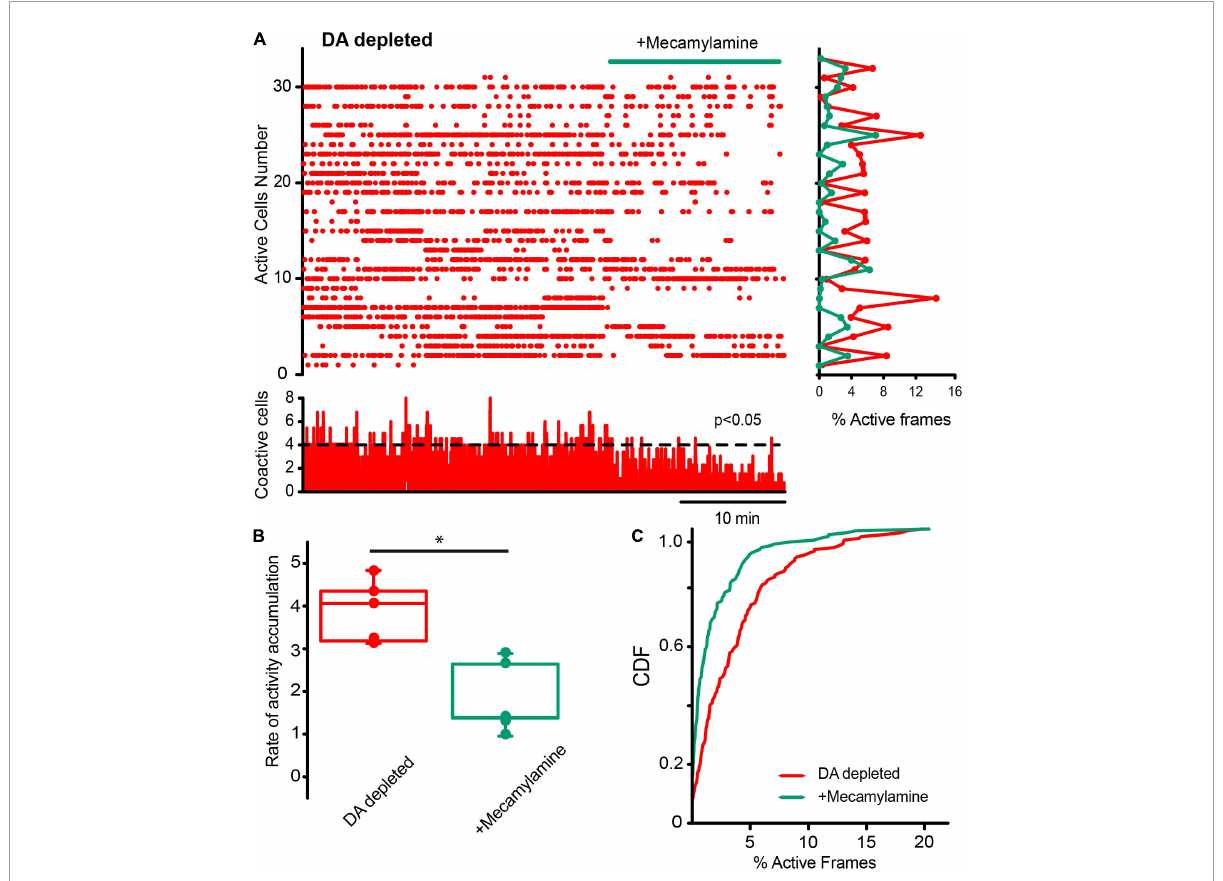
FIGURE12 Cholinergic synaptic transmission via nicotinic receptors is also important to maintain cholinergic interneurons hyperactivity in DA-depleted tissue. (A) Raster plot shows CINs hyperactivity in DA-depleted conditions. The addition of 10 µ M of mecamylamine, a nicotinic receptor antagonist, appears to decrease this hyperactivity neuron by neuron (histogram at right) and in significant peaks of coactivity (histogram at the bottom). (B) Box plots show that the rate of activity accumulation along time is, in fact, decreased ( n = 6; P = 0.05; Wilcoxon T -test). (C) CDFs show differences between activity of CINs during DA-depleted conditions before and after mecamylamine: P < 0.0001 (n-DA depleted CINs = 148 neurons; n-plus mecamylamine = 141 neurons, from n = 6 slices from 6 different animals: Kolmogorov-Smirnov